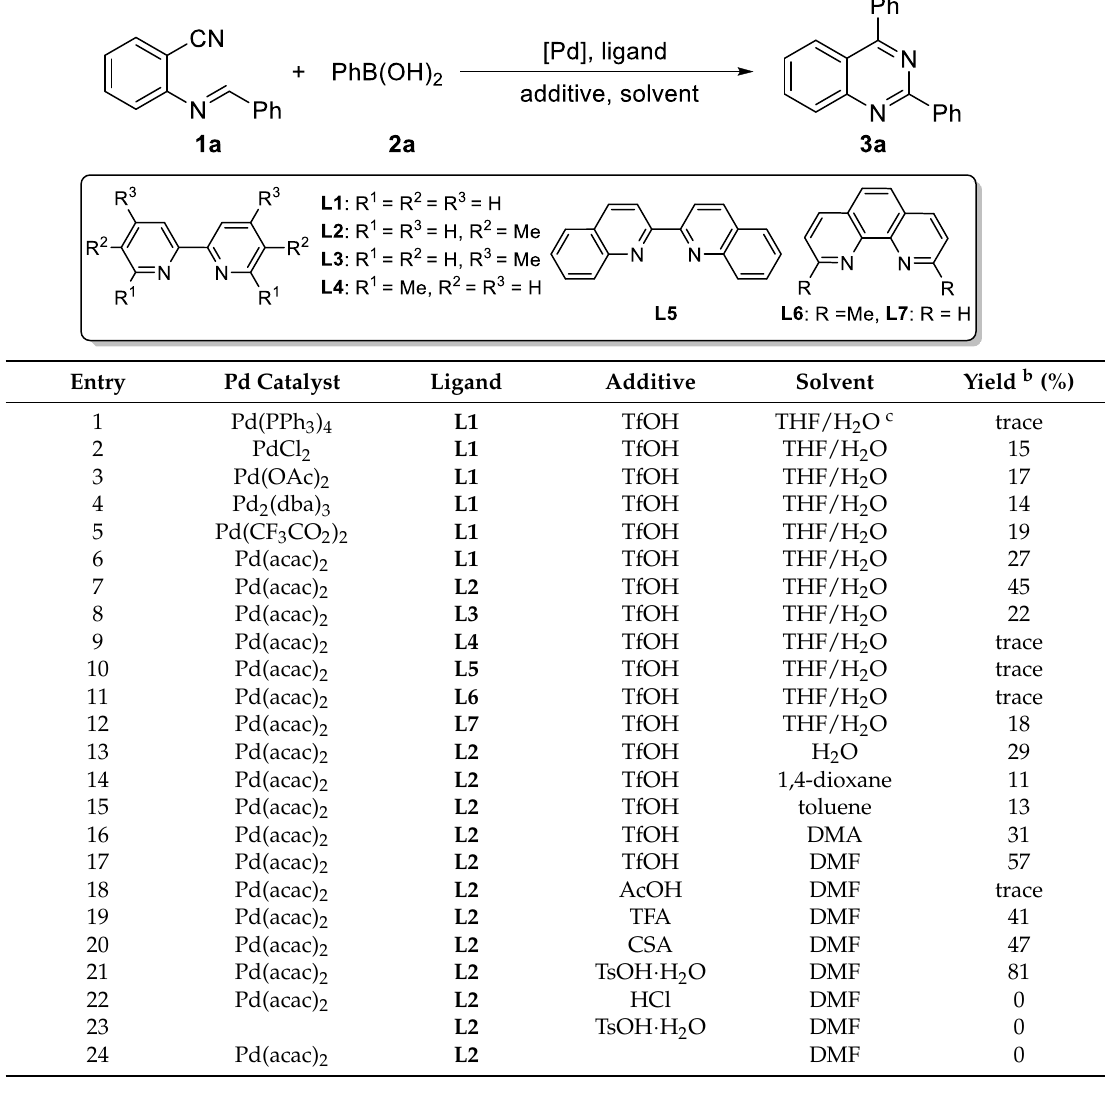
Table 1. Optimization of the reaction conditions a .